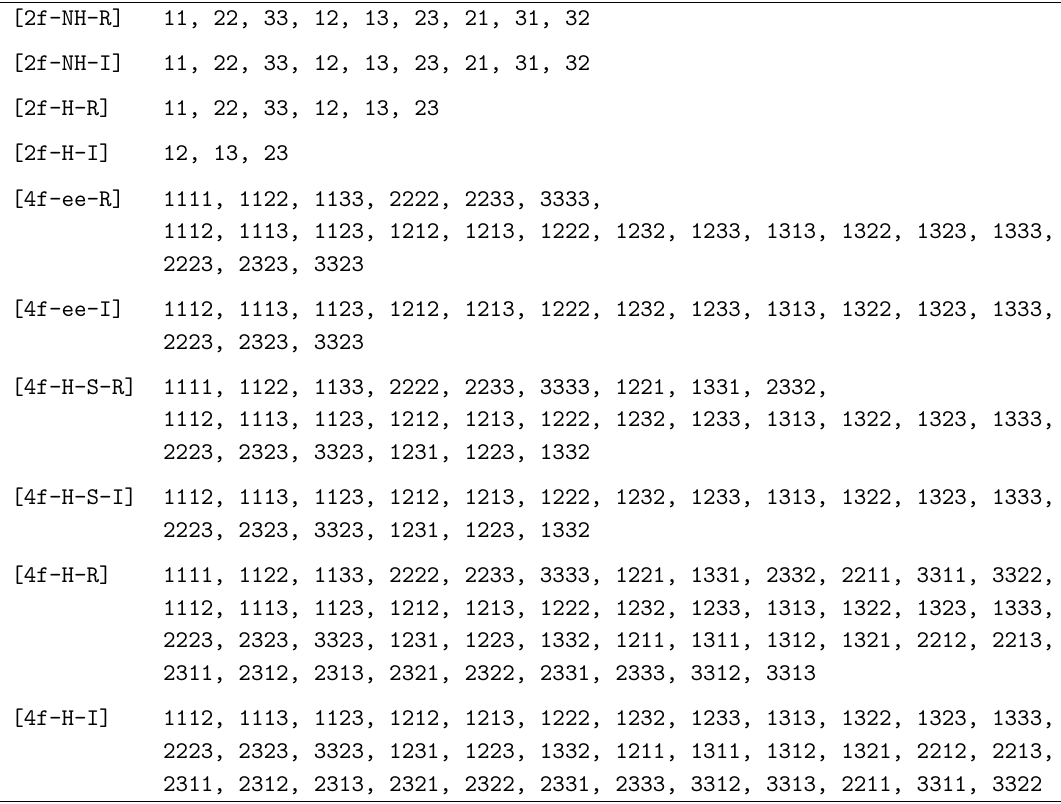
Table 19 . Sets of indices implemented for each category of fermionic operator in the general